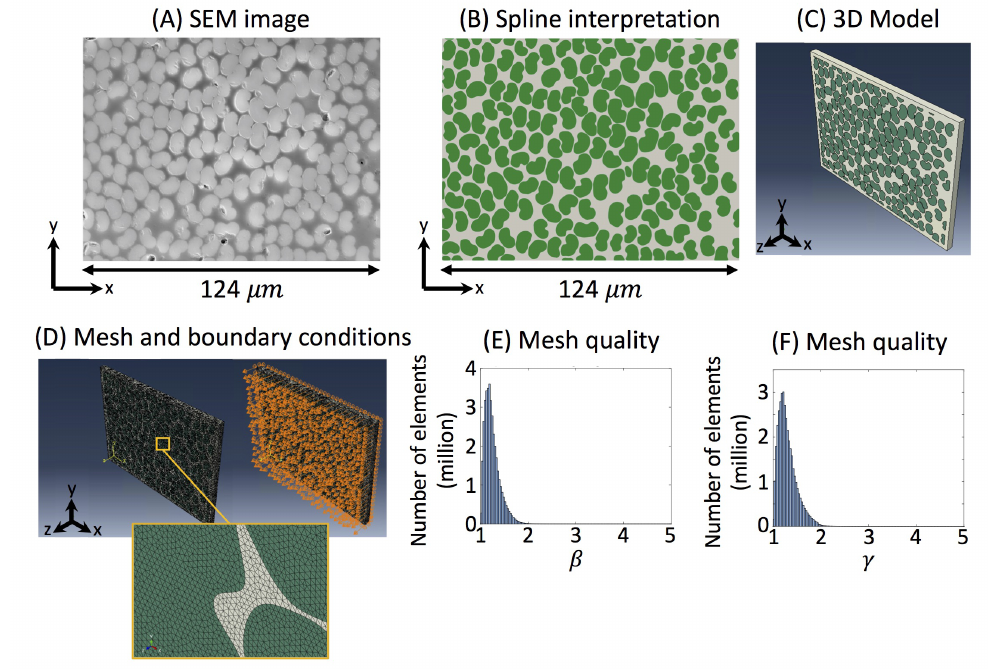
Figure 2. A SEM of the microstructure is shown in ( A ), where ( B ) shows the fiber detection and spline interpretation, ( C ) shows the 3D model with a 5 µ m thickness used in this work, and ( D ) is the mesh and the boundary conditions, where the -X, -Y, and -Z surfaces had roller boundary conditions, and the +Z surface had a roller boundary condition with a displacement of +0.075 µ m. The mesh quality is shown in ( E ) for β , and in ( F ) for γ